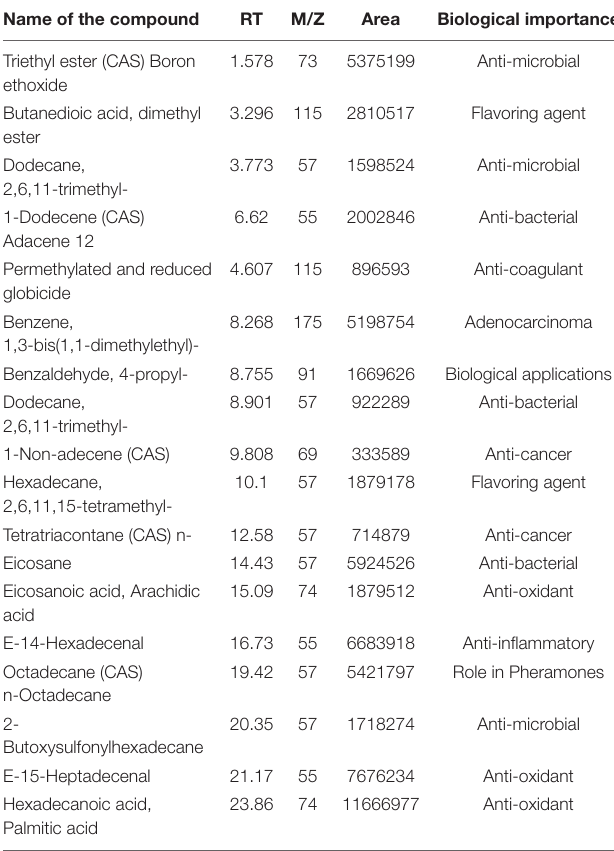
TABLE 1 | Volatile fatty acid composition of toddy palm nectar detected by GC-MS (gas chromatography and mass